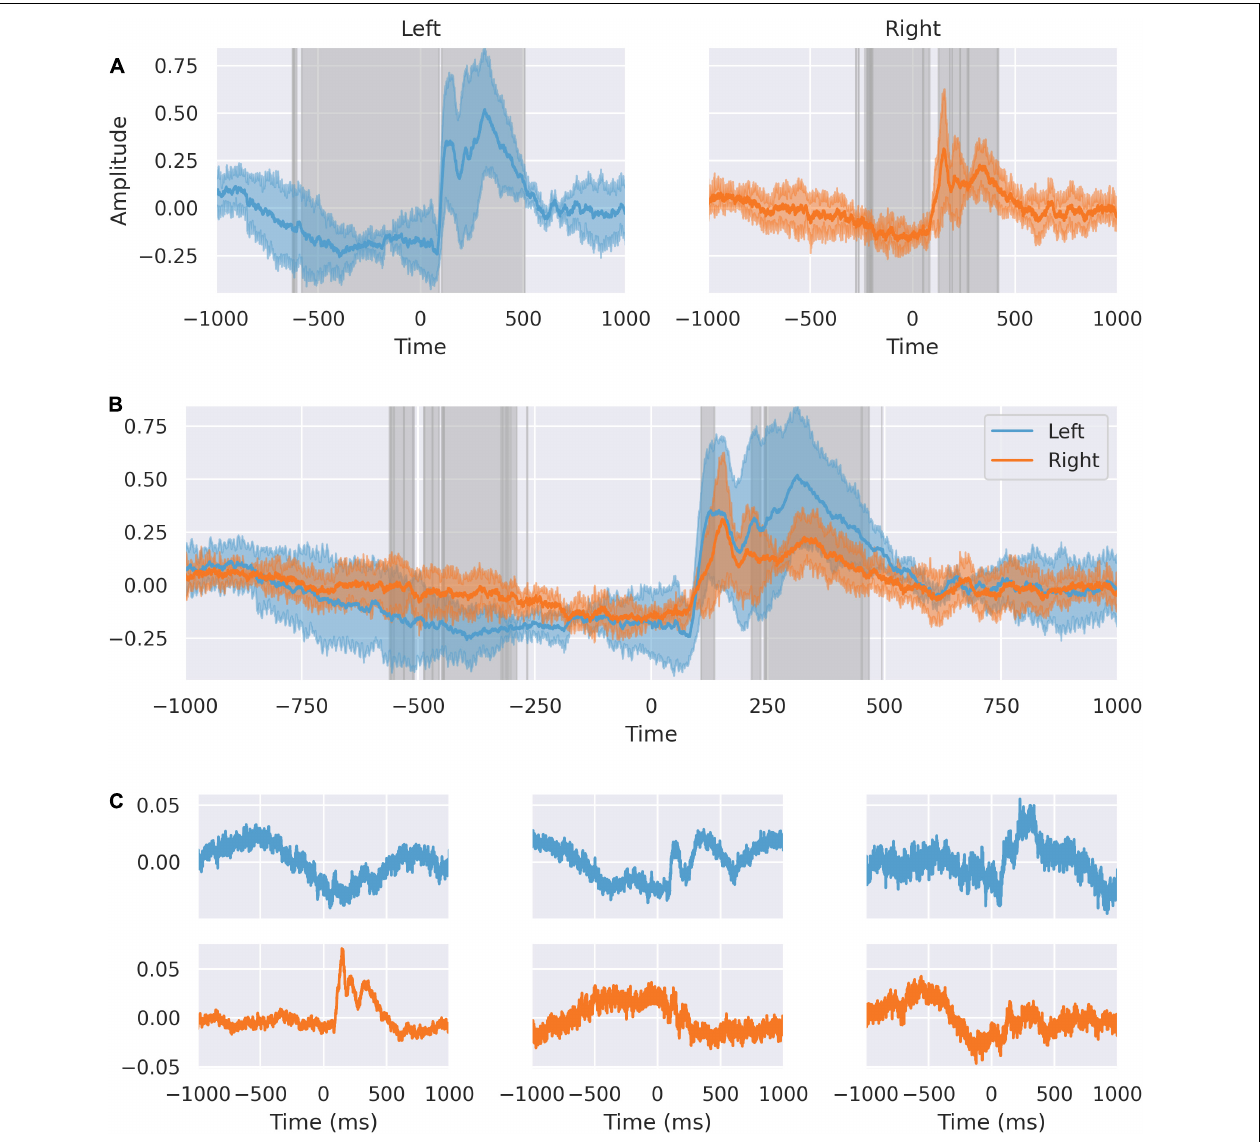
FIGURE 2 | The dACC response is lateralized. (A) Response of left and right dACC. Highlighted regions show where activity is statistically significant. Left dACC prefeedback interval begins earlier corresponding to when movement is occurring. (B) Response of left and right superimposed. Highlighted regions show statistically significant differences between left and right. There is an interval from 106 to 135 ms representing the peak lag between sides. The 242–566 ms interval shows differences in the response to feedback between left and right. (C) Source decomposition of signals from left (blue) and right (orange) dACC. Independent sources within the left and right dACC respond differently, with a stronger feedback response in the left ACC and more predictive activity in the right ACC.